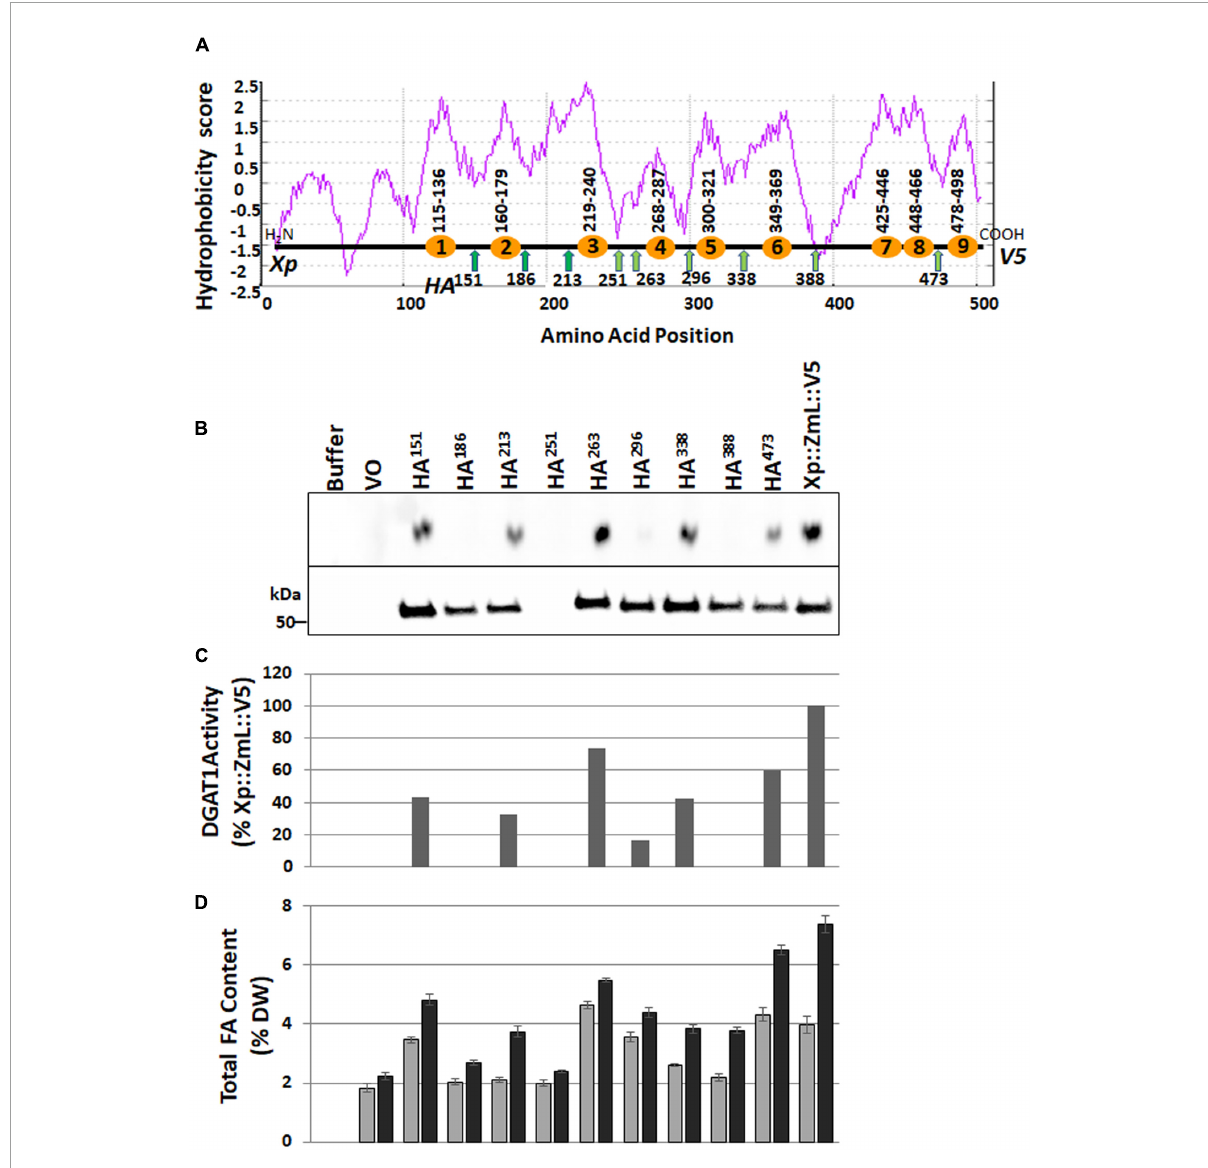
FIGURE3 Schematic representations of ZmL DGAT1 and influence of internal HA epitope tags on accumulation of recombinant ZmL DGAT1 protein, specific activity and total lipid content. (A) Hydrophobicity score aligned with the position of the TMpred (https://sbcb.bioch.ox.ac.uk/, Hofmann and Stoffel, 1993) predicted transmembrane domains are shown as orange circles; the number range above each circle indicate the predicted first and last residues of the domain. The positions of the engineered internal HA tags are shown as green arrows, the number below each arrow is the position of the N-terminal residue of the tag (only one HA tag was used per construct). Xp represents the X-press tag and V5 represents the C-terminal tag. (B) The upper panel shows the amounts of triacylglycerol produced by the corresponding recombinant DGAT1. Equivalent quantities of microsomal protein were used in an in vitro DGAT1 activity assay. The lower panel shows an immunoblot that had been loaded with equivalent quantities of microsomal protein from 24 h yeast cultures and probed using the anti V5 antibody. No recombinant protein was detected in the culture expressing Xp::ZmL-HA 251 ::V5 (upper panel). (C) The relative specific activity of the internally HA tagged ZmL constructs. The results were adjusted for the level of recombinant DGAT1 (after the V5 signals were quantified with Image Lab Software, V4.1, Bio-Rad) in the microsomal preparations and the quantities of TAG were then normalized to the quantity of TAG produced by the Xp::ZmL::V5. (D) The total FA content of the yeast cultures as a% of cell DW after 24 (gray bars) and 48 h (black bars) of growth.